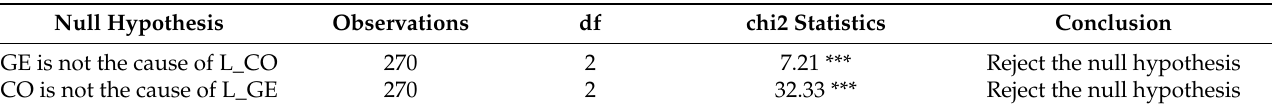
Table 10. Granger causality test